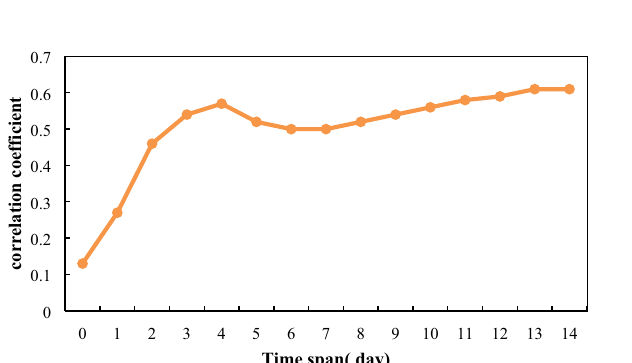
Figure 5. The correlation coefficients between Wuhan population flow and cumulative confirmed cases, excluding Hubei, considering different time